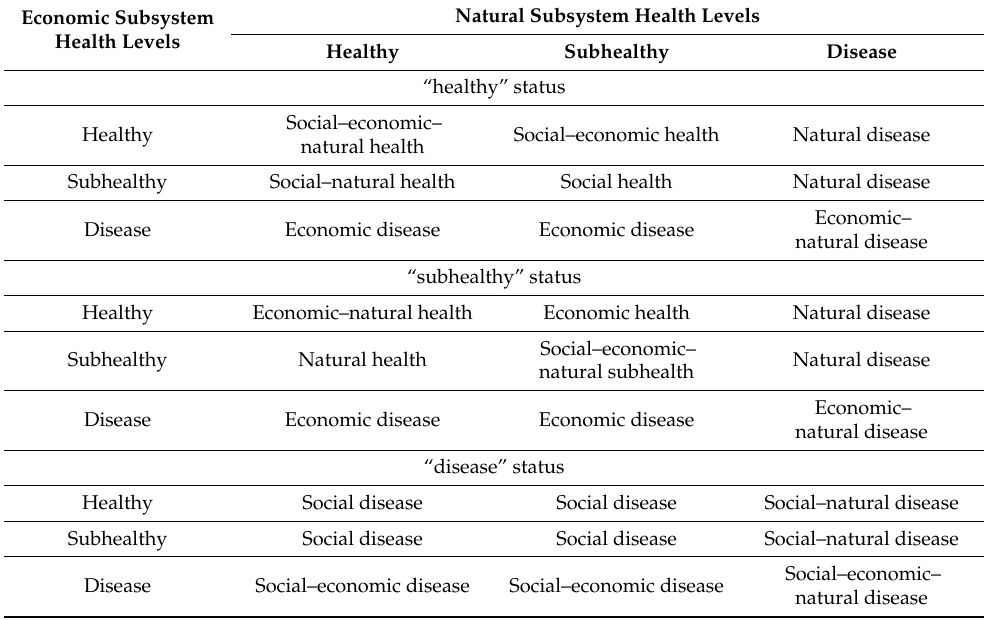
Table 3. Health classification when the social subsystem has a “healthy”, “subhealthy” and “disease”